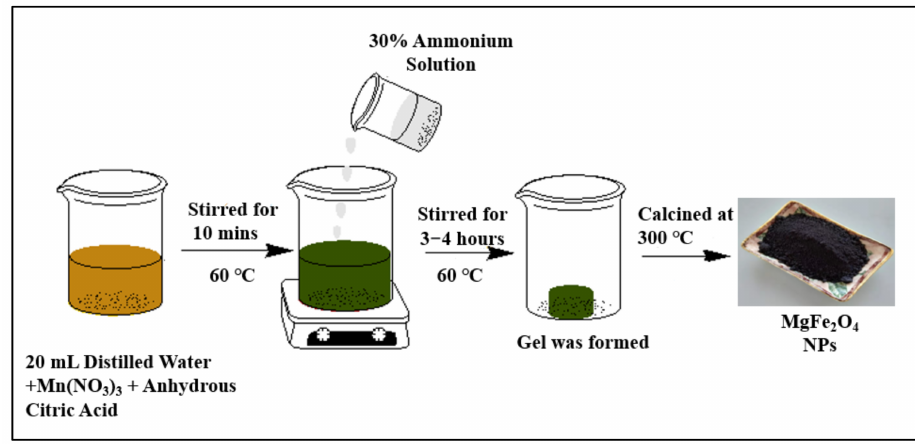
Scheme 1. Synthesis of magnesium ferrite nanoparticles using sol-gel method.